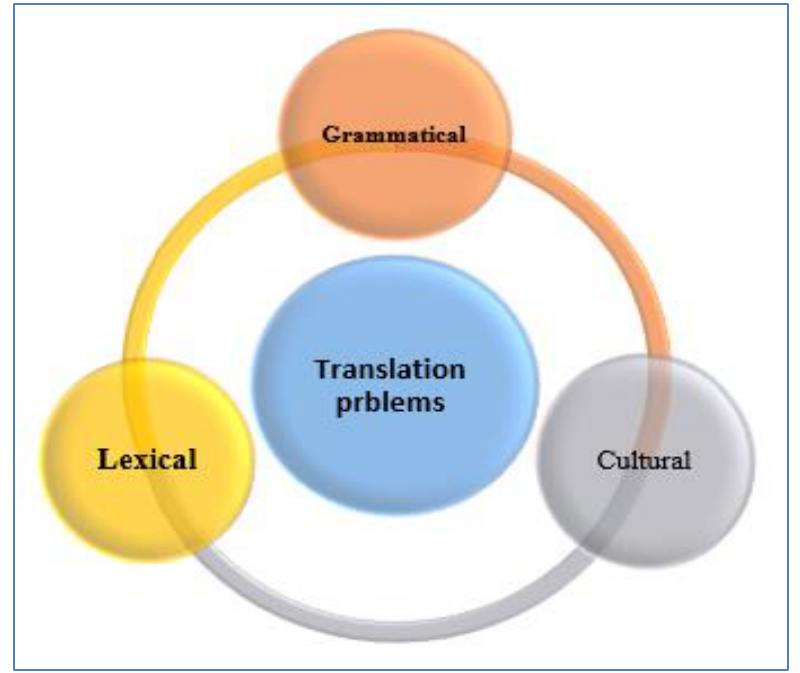
Figure 1. Types of the Participates’ Translation